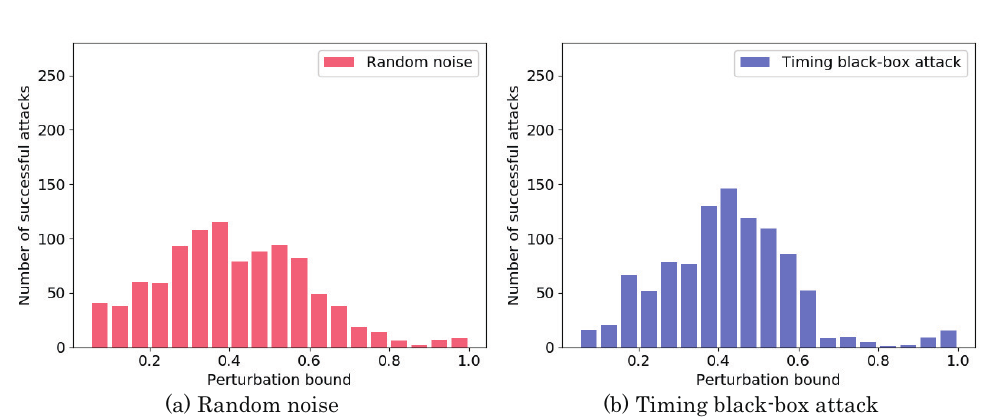
Figure 17: Histogram of successful attacks against countermeasure on 1,000 samples of MNIST dataset. Proposed attack is compared with random noise. Each perturbation bound is plotted when misclassification is caused by proposed attack and random